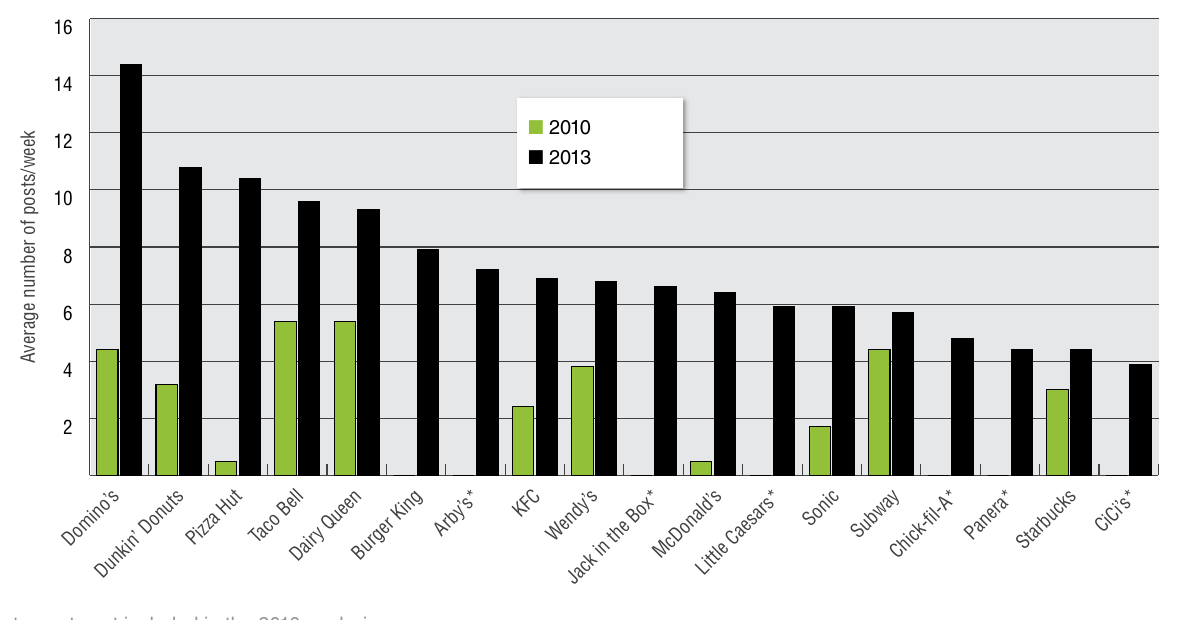
Figure 13. Average number of posts per week on restaurants' Facebook pages